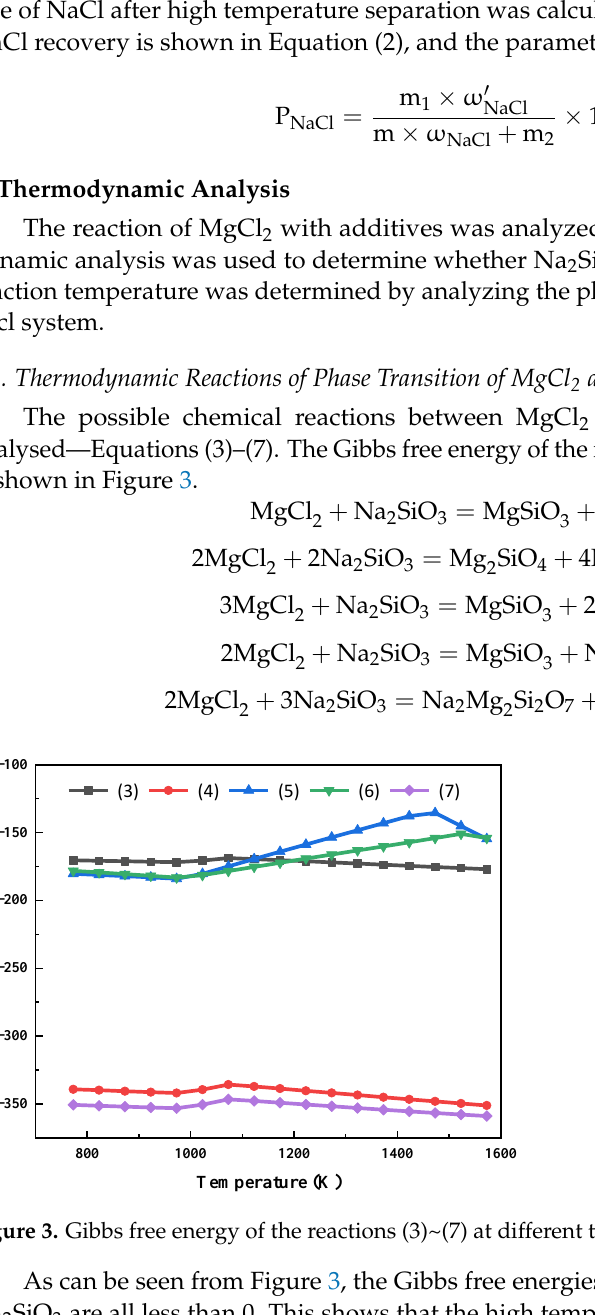
Figure 4. Ternary phase diagram of MgCl 2 -Na 2 SiO 3 -NaCl system at 1073 K. (l — liquid; s — solid).